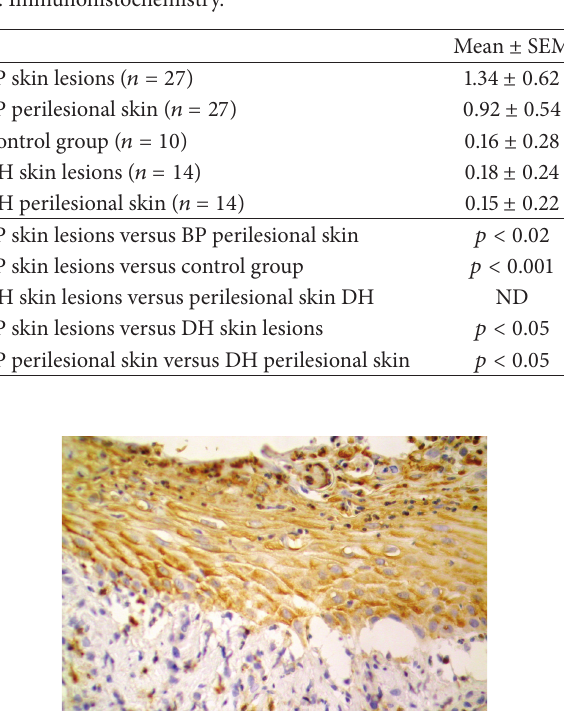
Table 1: Morphometric analysis of TF expression in skin lesions and in perilesional skin (in keratinocytes and infiltrates) in patients with BP. Immunohistochemistry.